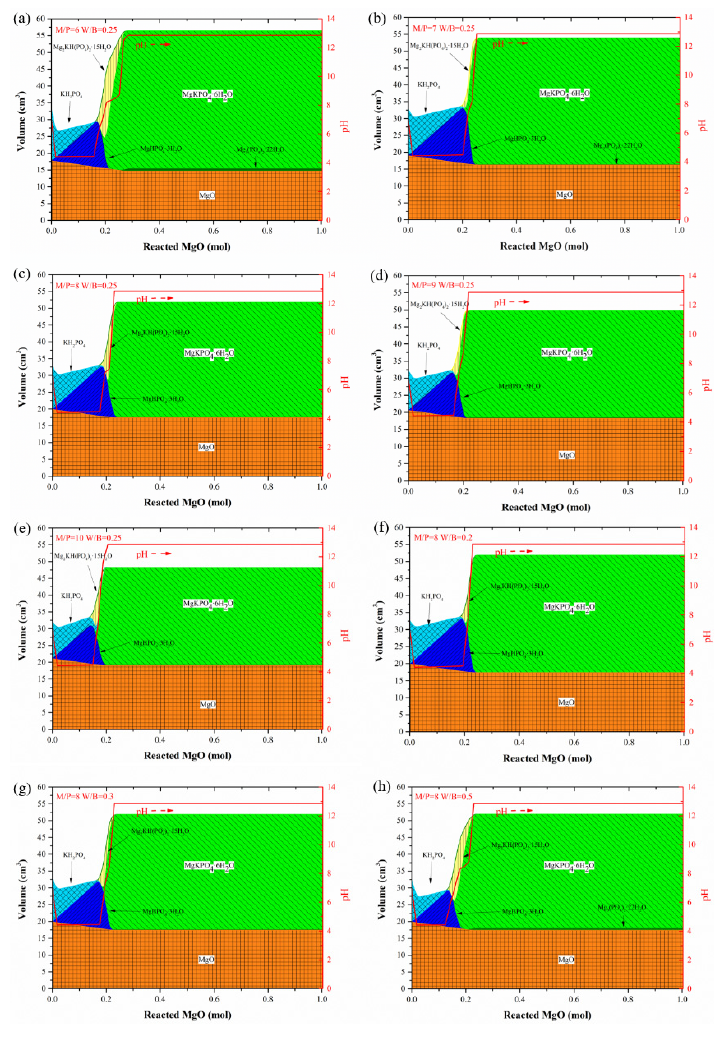
Figure 2. Evolution of volume of hydration products and pH values with the reacted amount of MgO in ( a ) MP6H0.25K; ( b ) MP7H0.25K; ( c ) MP8H0.25K; ( d ) MP9H0.25K; ( e ) MP10H0.25K; ( f ) MP8H0.2K; ( g ) MP8H0.3K; and ( h )